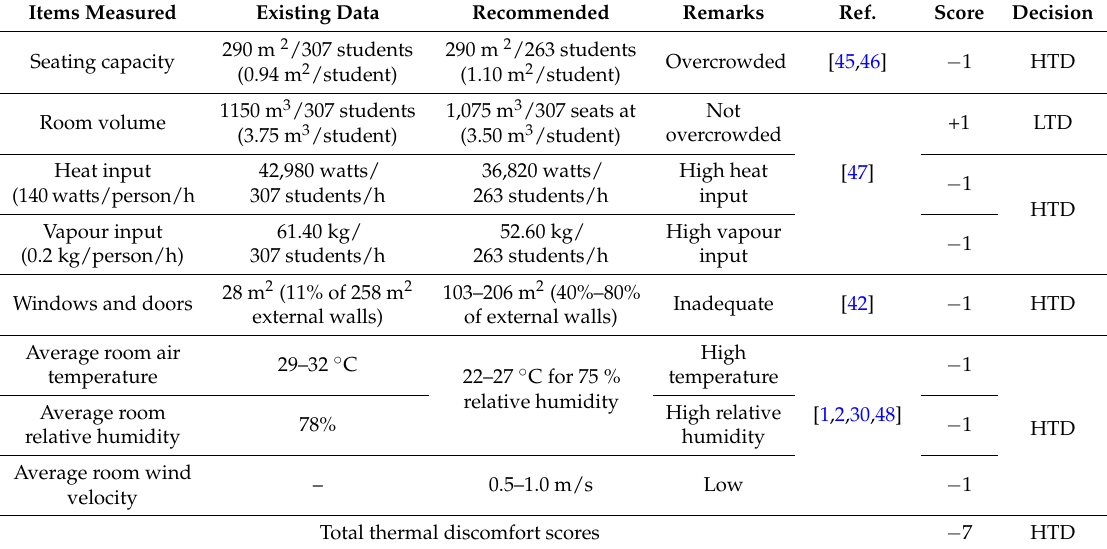
Table 1. Measurement of indoor space and environmental conditions in